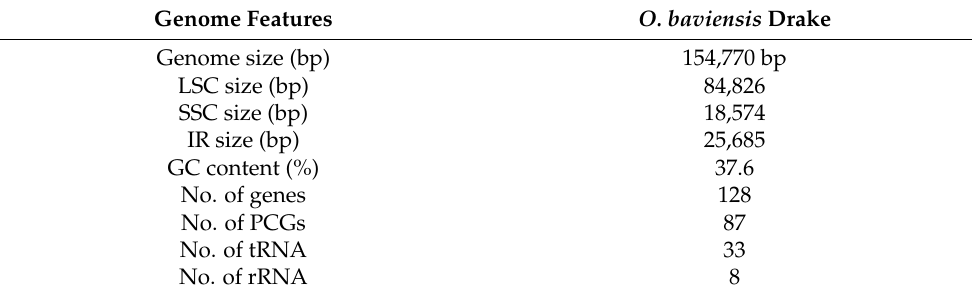
Table 1. Summary of the chloroplast genome of O. baviensis Drake species.